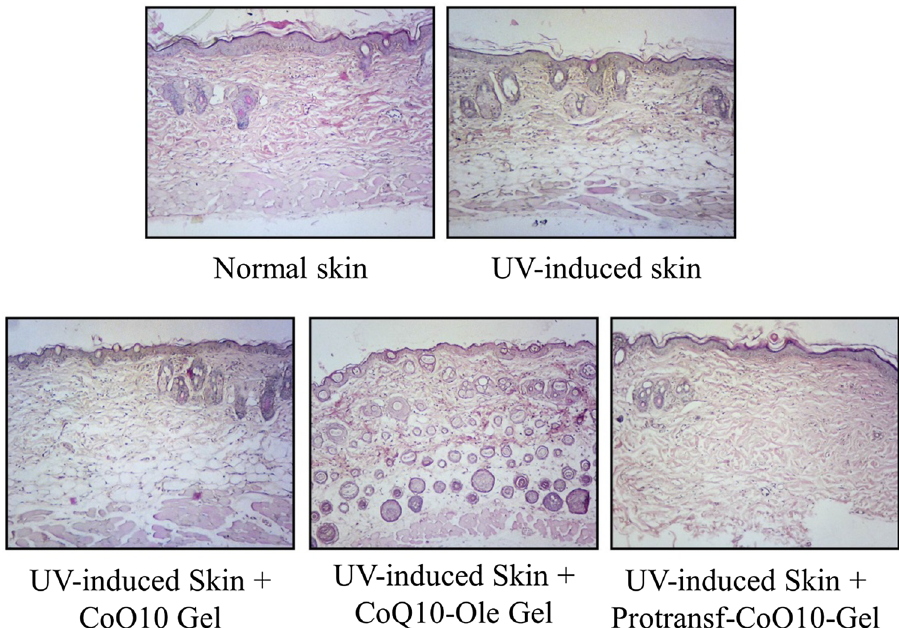
Figure 8. The histopathology of mice back skin stained with hematoxylin–eosin without and with UV-induced photoageing at 24 h after topically applied with saline (Normal skin and UV-induced skin), CoQ10-loaded Emulgel, CoQ10 dissolved in oleic acid (CoQ10-Ole) Emulgel, and protransfesomal CoQ10 (Protransf-CoQ10) Emulgel.